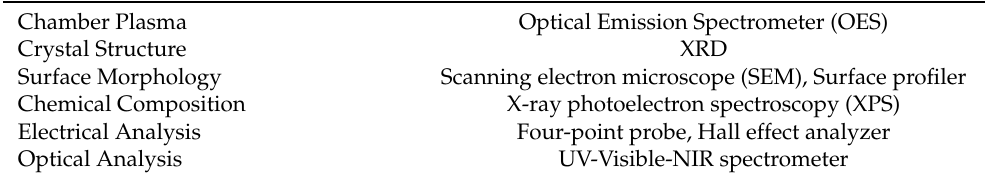
Table 1. Experimental plan for material